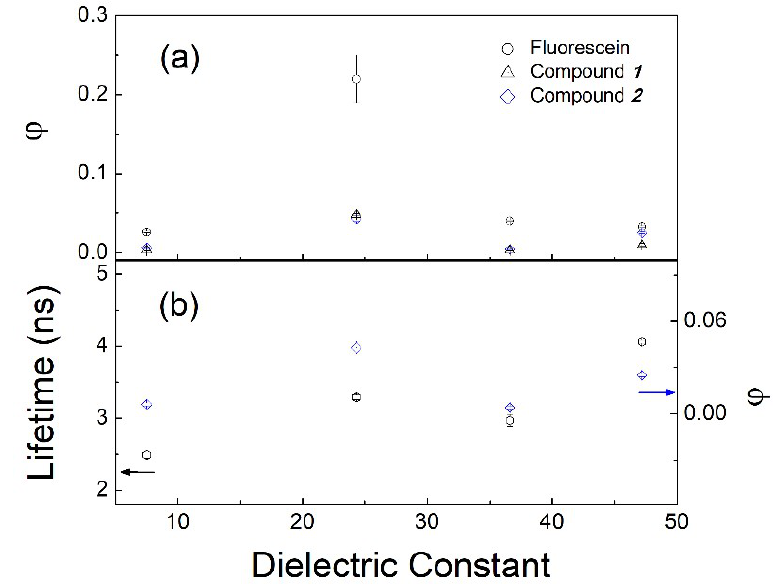
Figure 5. ( a ) Relative quantum yield of compounds 1 , 2 and fluorescein at λ e = (432 ± 7) nm as a function of the dielectric constant. ( b ) Lifetime and φ of compound 2 .